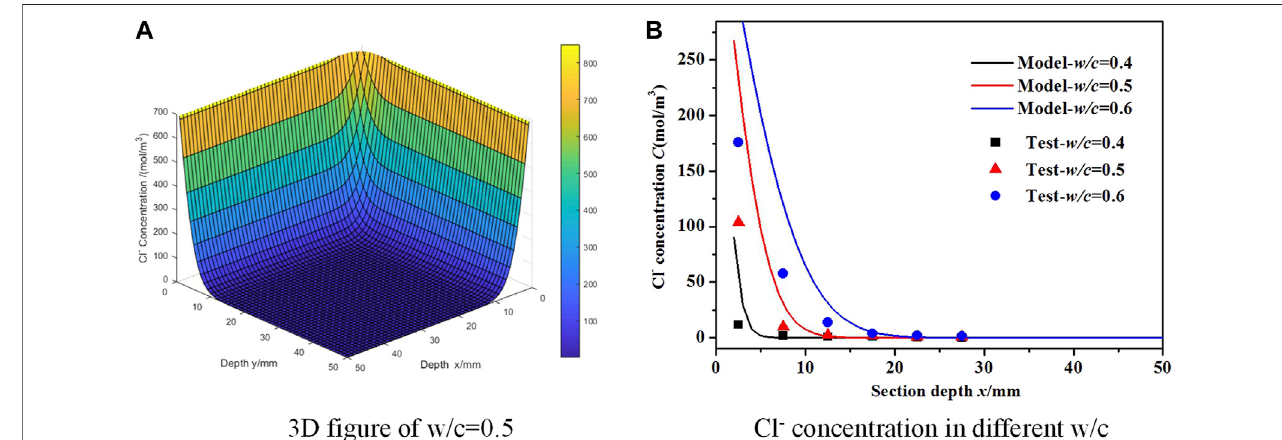
FIGURE 9 | Comparison between experimental and theoretical Cl −